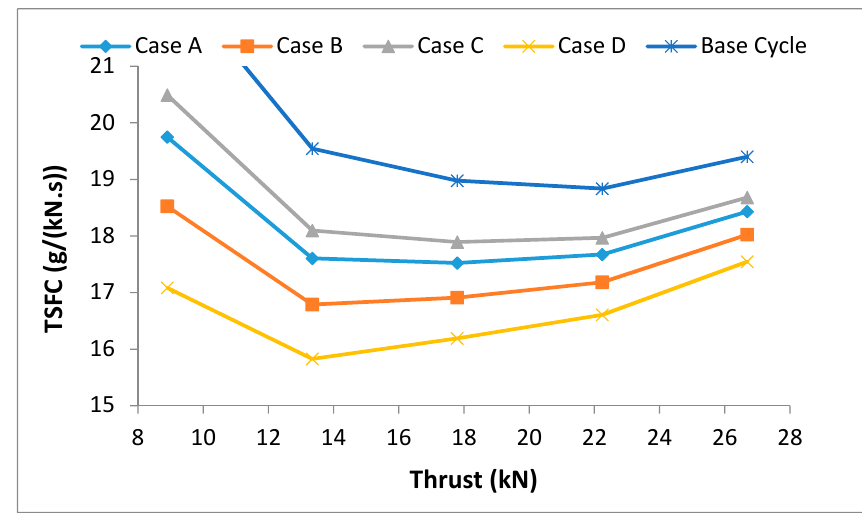
Figure 12. Graph of Thrust-Specific Fuel Consumption (TSFC) against thrust.